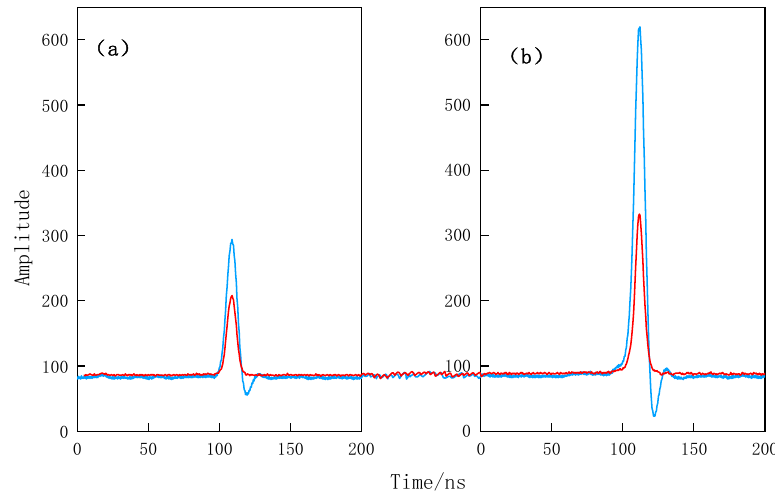
Figure 5. Schematic diagram of high- and low-gain comparison of laser emission waveform ( a ) and echo waveform ( b ). The blue solid line is the high-gain waveform and the red solid line is the low- gain waveform.